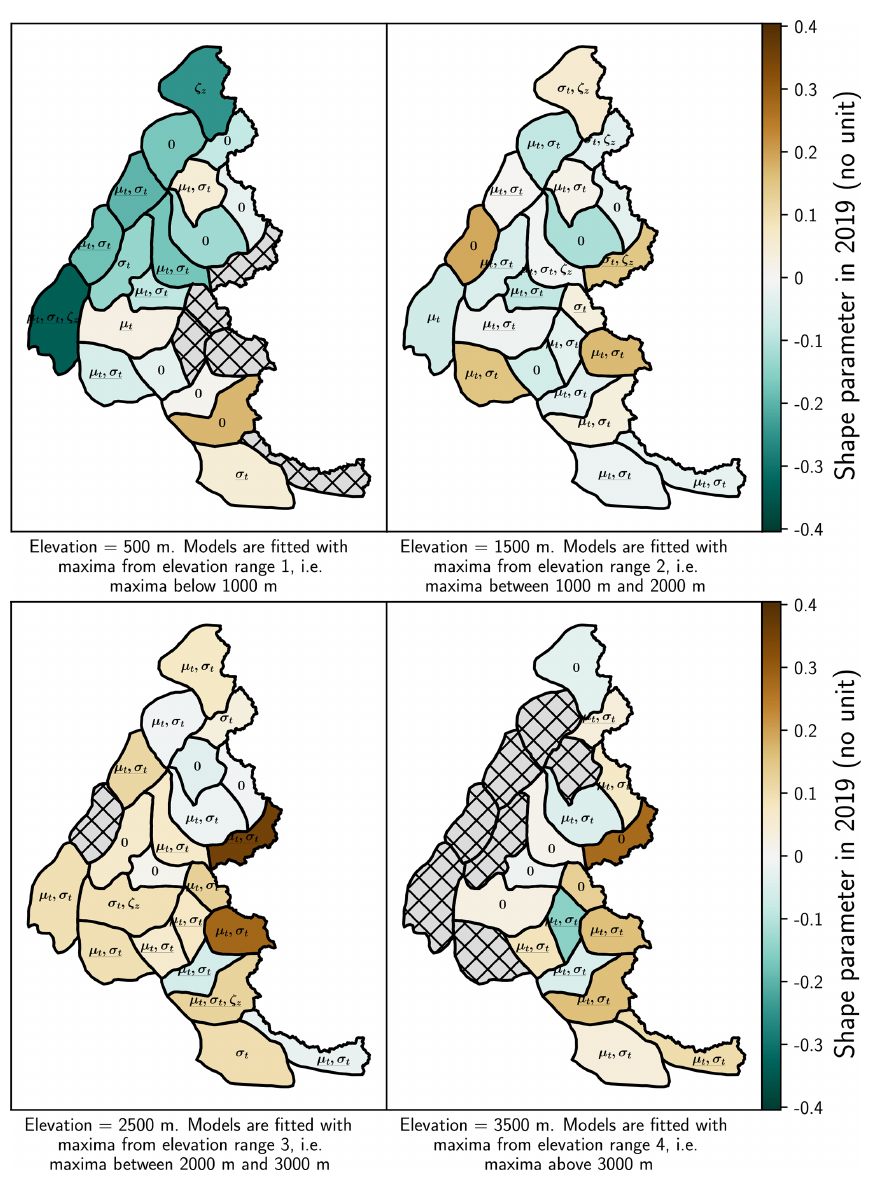
Figure 4. Selected models and shape parameter values for each range of elevations in the 23 massifs of the French Alps. We write the suffix of the name of each selected model on the map; e.g., we write µ t ,σ t for the model M µ significant trend (Sect. 3.3). Hatched grey areas denote missing data, e.g., when the elevation is above the top elevation of the massif. Shape parameter values are computed at the middle elevation for each range, e.g., at 1500m for the range